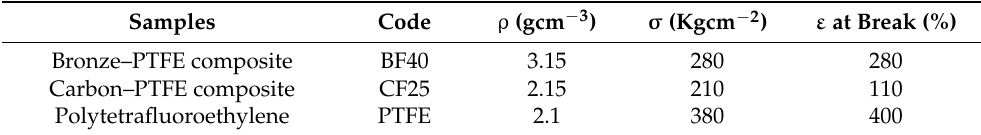
Table 1. Physical and mechanical properties of materials used in the study.